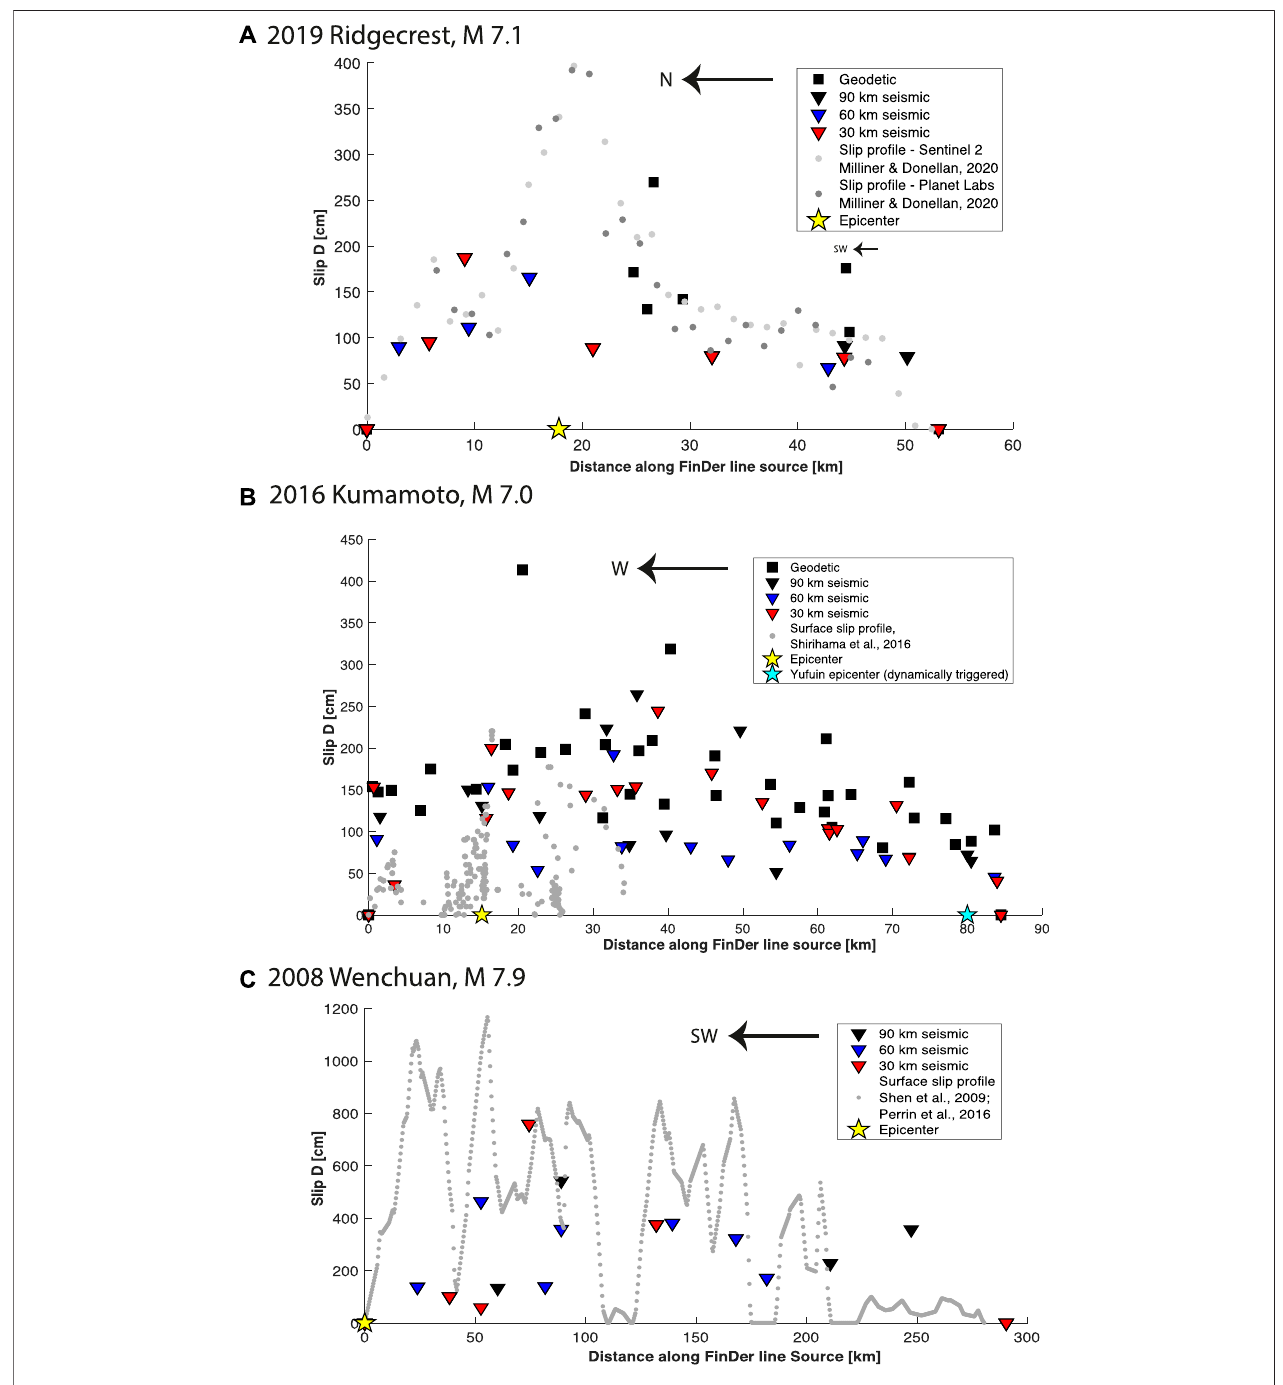
FIGURE2| Mapsshowingearthquakeepicenters(stars),seismicstrong-motionandgeodeticGNSSstations(trianglesandsquares,respectively),andFinDerline- source models (black lines) for the a) M W 7.1 Ridgecrest, California, b) M W 7.0 Kumamoto (and Yufuin), Japan, and c) M W 7.9 Wenchuan, China, earthquakes. The line- sourcemodelswerecalculatedfromseismicwaveformplaybackandcorrespondtothe fi nalFinDersolutionsat26,36,and124 s,respectively( Table1 ).Colorofstation markers shows their respective distance range relative to the FinDer line-source.